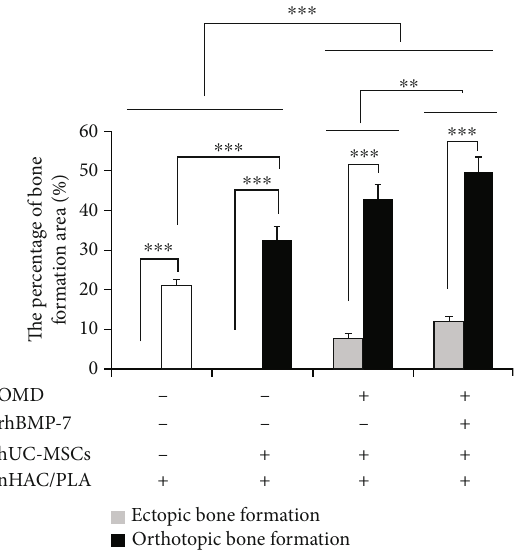
Figure 10: Percentage of bone formation area in the in vivo ectopic and orthotopic microenvironment after 3 months of surgery ( mean ± SD , n = 6 ). ∗∗ P < 0 : 01 ; ∗∗∗ P < 0 : 001